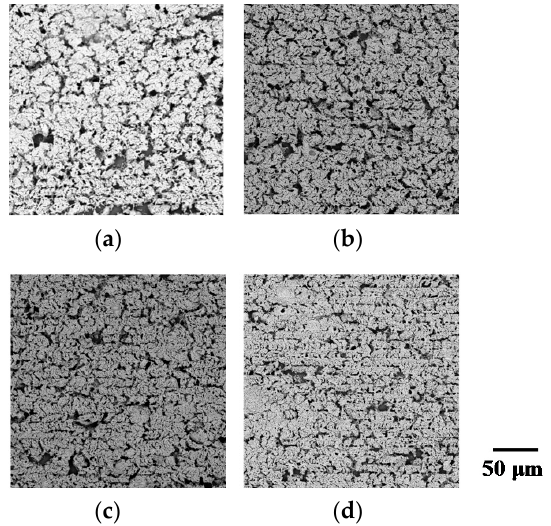
Figure 4. SEM images of the fabricated micropatterns at laser fluences of ( a ) 0.059 J/cm 2 , ( b ) 0.047 J/cm 2 µm/s, ( c ) 0.035 J/cm 2 , and ( d ) 0.024 J/cm 2 .